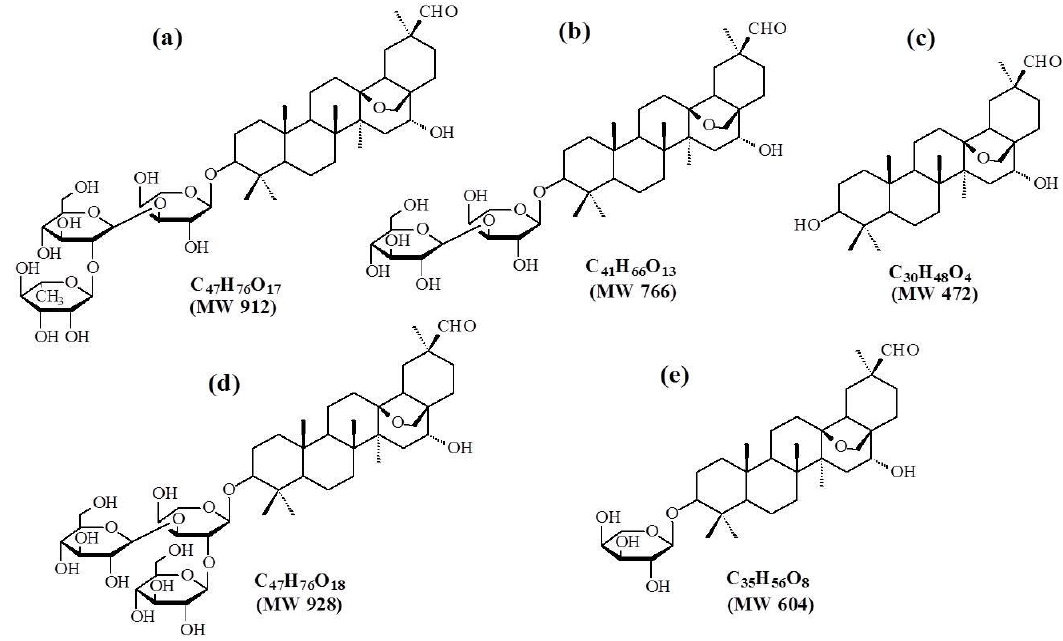
Figure 7. The possible structures of ADS-I intestinal bacteria metabolites, ( a – c ) the same metabolites of ADS-I by human and rat intestinal bacteria respectively; ( d ) the unique metabolite of ADS-I by rat intestinal bacteria; ( e ) the unique metabolite of ADS-I by human intestinal bacteria.